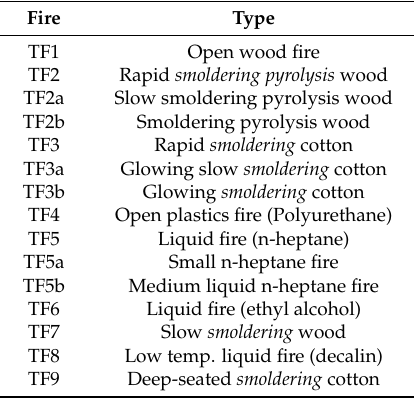
Table 3. Standard Test Fires described in the EN-54